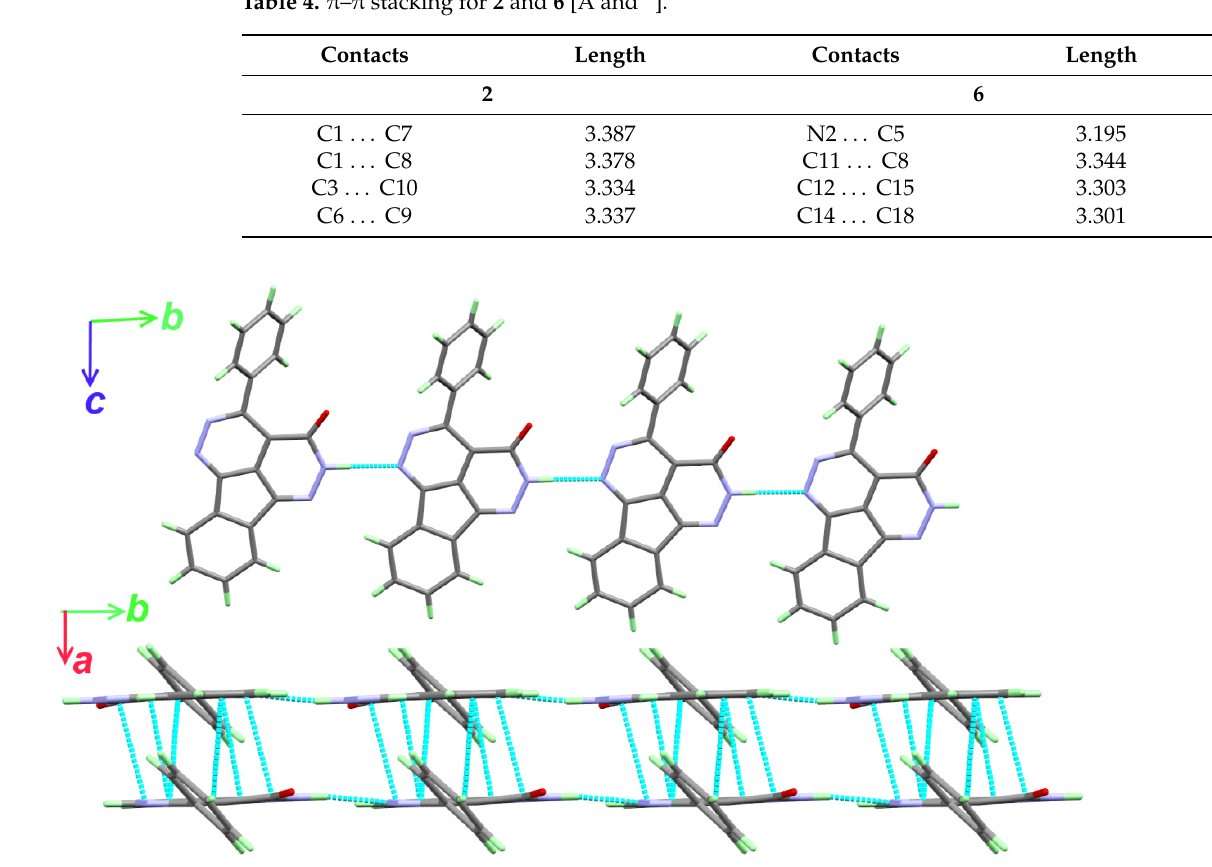
Figure 3. Packing via N-H . . . N hydrogen bonds and π – π stacking (lower) in 2 . Table 3. Hydrogen bonds for 2 [Å and °].